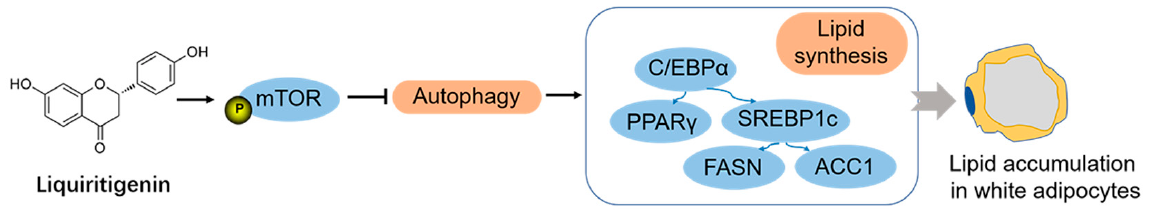
Figure 6. LQG reduced lipid accumulation in 3T3-L1 white adipocytes via mTOR-mediated autophagy mechanism.